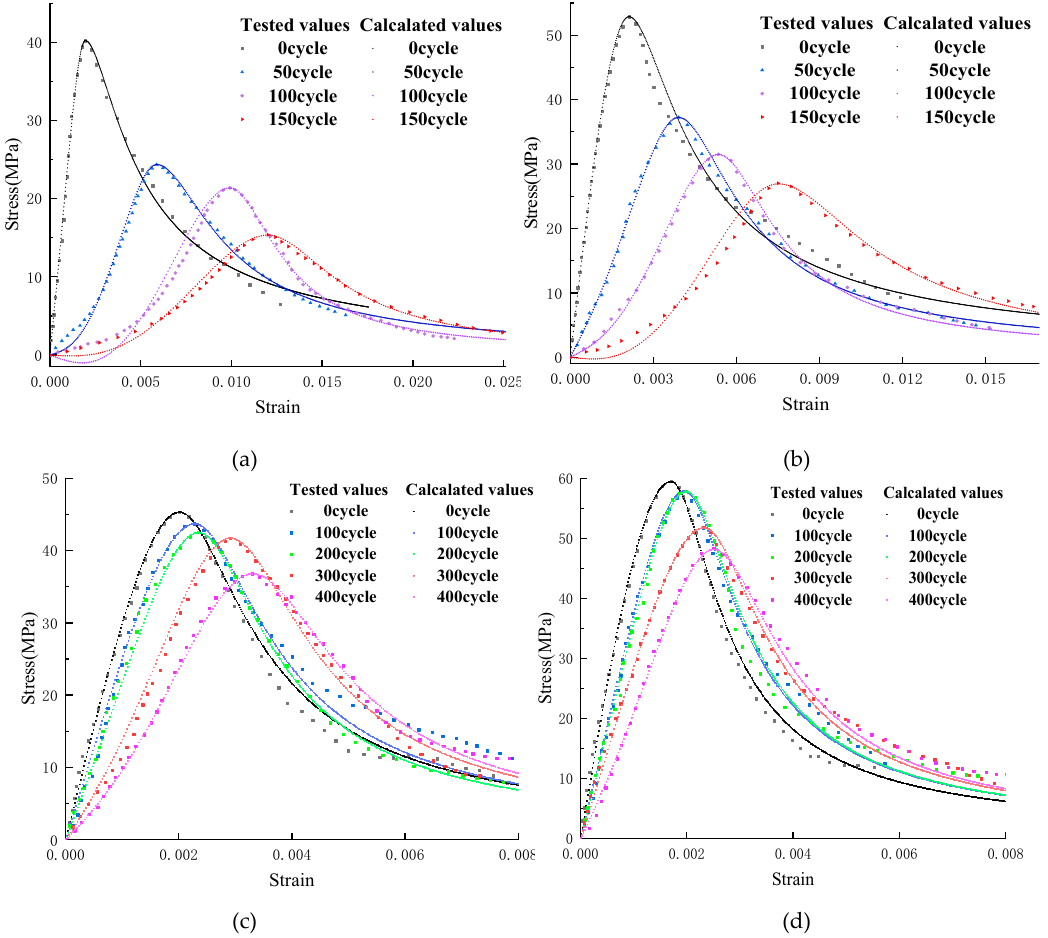
Figure 10. Comparison between the predicted stress–strain curve of freeze–thaw concrete and the measured one: (a) O-C40 concrete; (b) O-C40 concrete; (c) AE-C40 concrete; and (d) AE-C40 concrete.